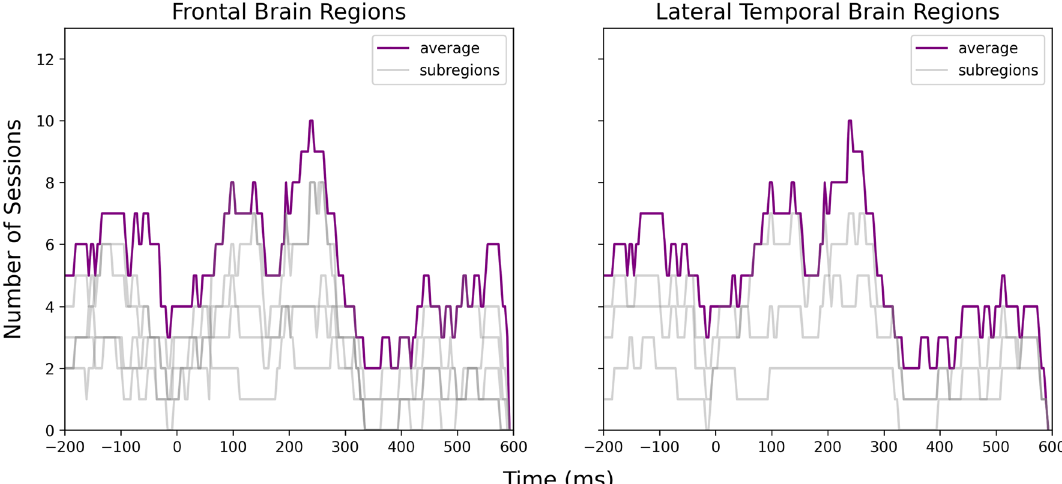
Figure 4. Number of sessions showing significant differences in the iEEG windows sampled around note onsets and the reference windows at each time point. The purple lines were obtained by averaging all channels within the frontal and lateral temporal brain regions. The light gray lines were obtained by averaging the channels within sub-regions that contributed to the frontal and lateral temporal